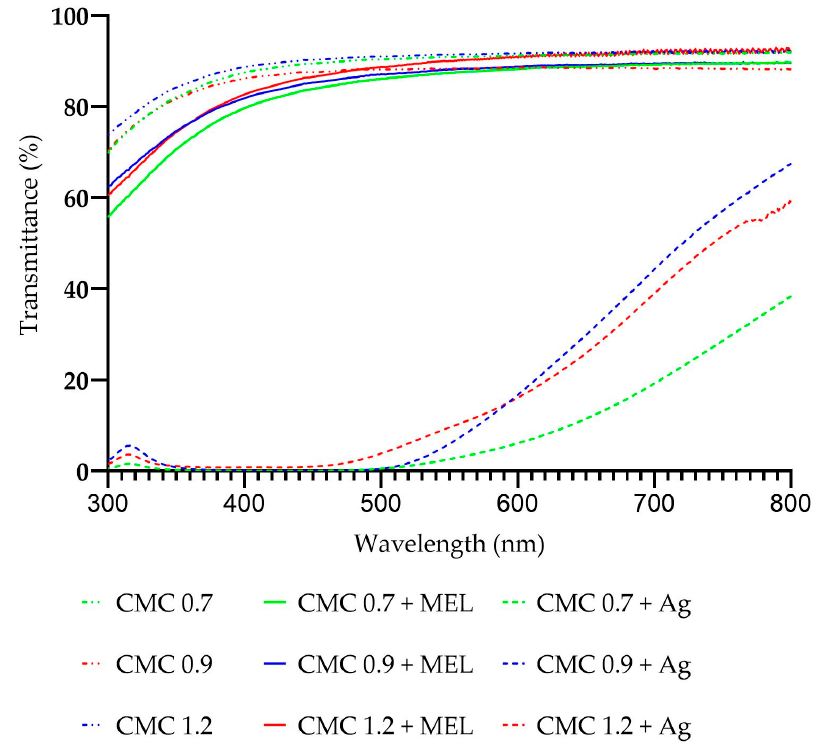
Figure 1. UV–Vis spectra of unmodified, melanin-modified and AgNP-modified CMC films.